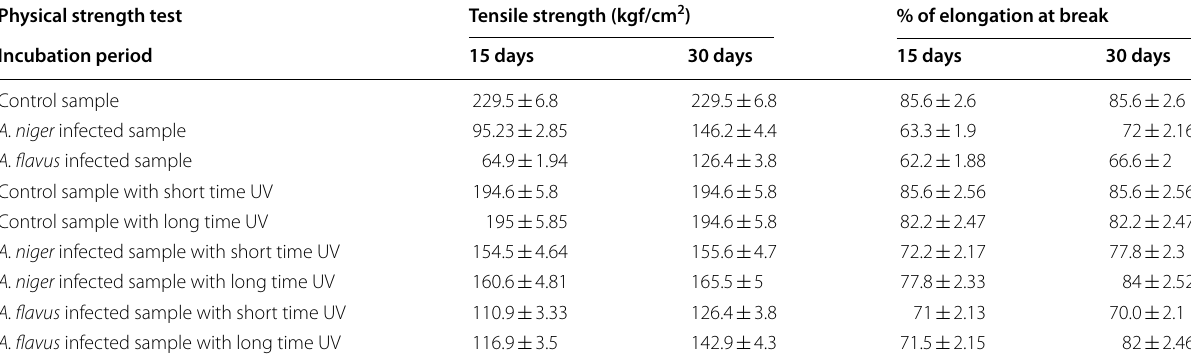
Table 2 Tensile strength and percentage of elongation at break of chrome tanned leather sample Physical strength